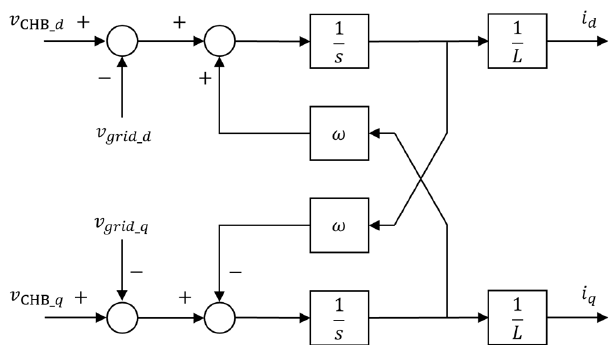
Figure 6. Block diagram of a three-phase inductor in the dq frame.